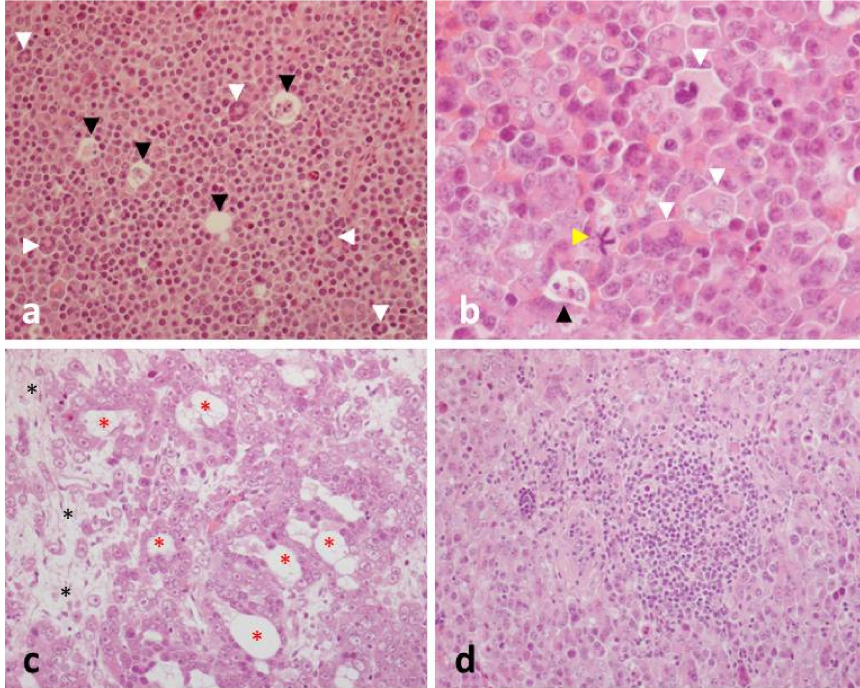
Figure 8. Horse testis. ( a ) Neoplastic cells are densely packed, and multinucleated cells can be easily detected (white arrowheads). Individual cell death (black arrowheads) determines a starry- sky pattern. ( b ) At a higher magnification, the main features of the neoplastic cells are better appreciated. Most of them are mononuclear and polygonal in shape, with a central, often vesicular nucleus, surrounded by a more or less abundant eosinophilic cytoplasm. Prominent nucleoli are also evident. Multinucleated cells usually have their nuclei arranged in a horseshoe-shaped pattern, at the cell periphery. The apoptosis of a single cell (black arrowhead) and an atypical mitosis (yellow arrowhead) are also seen. ( c ) Neoplastic cells are arranged as cords, tubular-like structures (red asterisks) embedded within nucleoli are very evident, and the stroma shows a loose appearance. ( d ) A lymphocytic aggregate is shown embedded within the neoplastic proliferation. Hematoxylin and eosin stain. Final magnification: × 200 ( a , c , d ), × 400 ( b ). Three months after surgery, a follow-up evaluation showed no other changes in the right testicle. Hematology and serum-biochemical panels were repeated, with